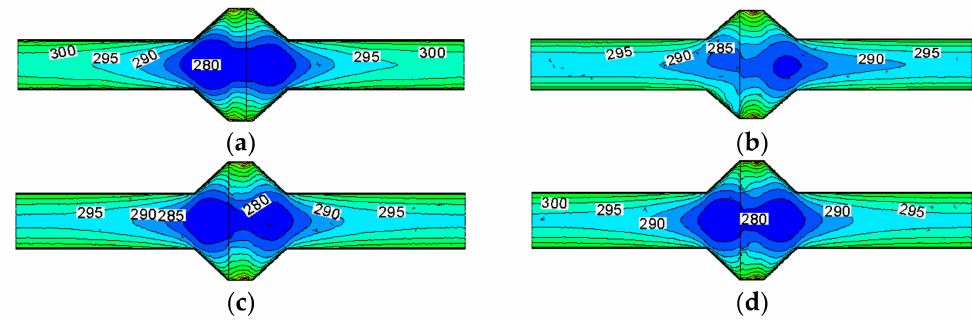
Figure 15. Temperature distributions at the X-axis central section in five cases at Re = 27,900. ( a ) BP case; ( b ) one-circle case; ( c ) two-circle case; ( d ) three-circle